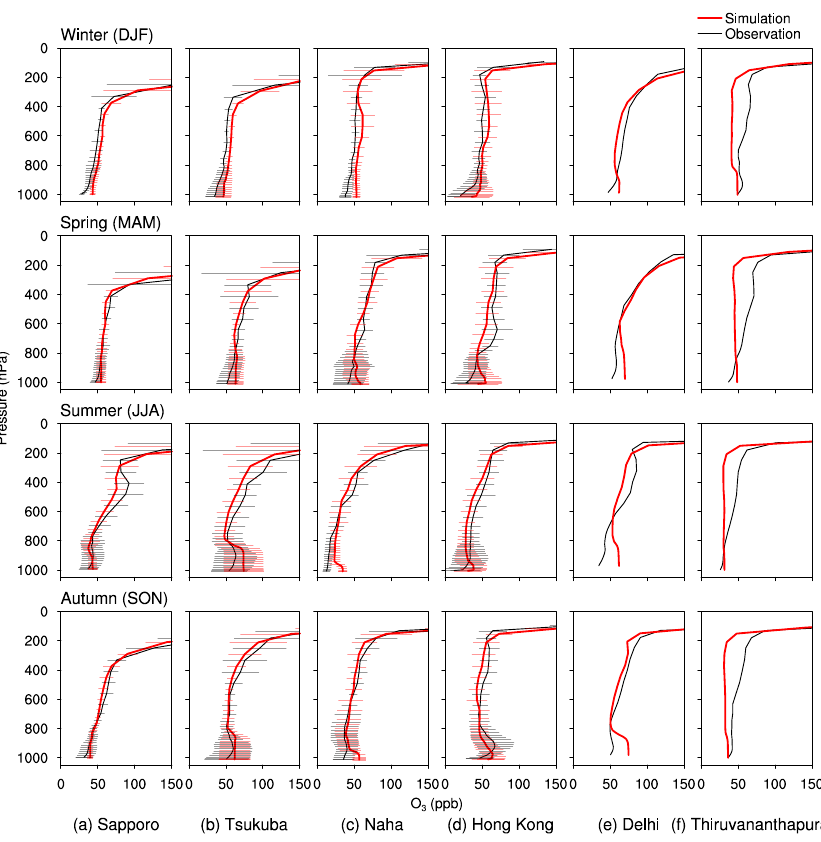
Figure 5. Vertical profiles of observed and simulated ozone concentration in BASE for 2010 at six monitoring stations. Values are averaged over all ozonesonde measurements within each season at Sapporo, Tsukuba, Naha, and Hong Kong. Error bars represent standard deviations. Simulated seasonal mean values are compared with values averaged over all available ozonesonde measurements within each season during 2000–2011 at Delhi and